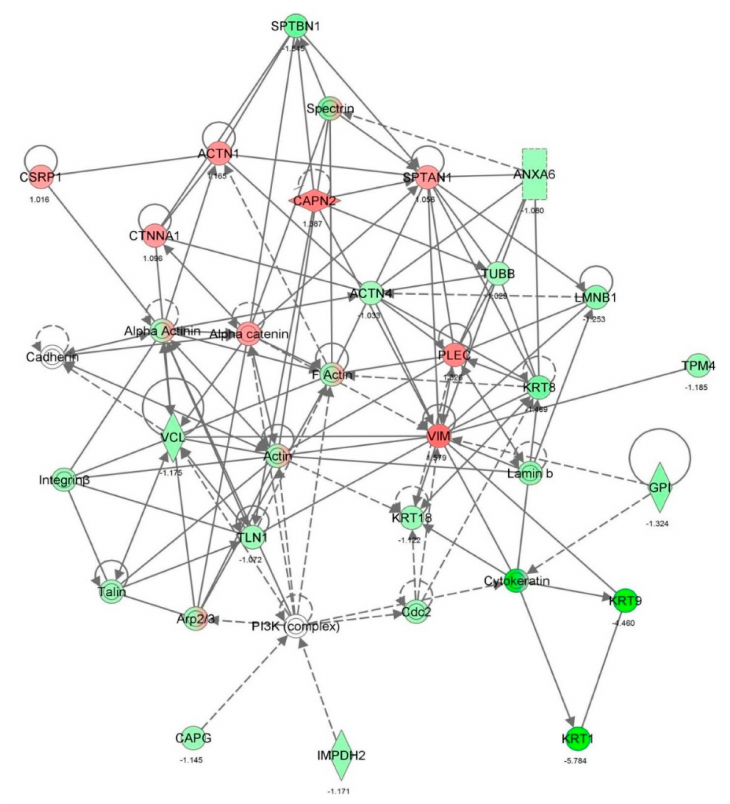
Figure 14. Vancomycin regulated cellular compromise, cellular assembly and organization, and cellular function and maintenance. Red indicates an up-regulation; green indicates a down-regulation. The intensity of green and red colors indicates the degree of down- or up-regulation. Solid arrow indicates direct interaction and dashed arrow indicates indirect interaction.